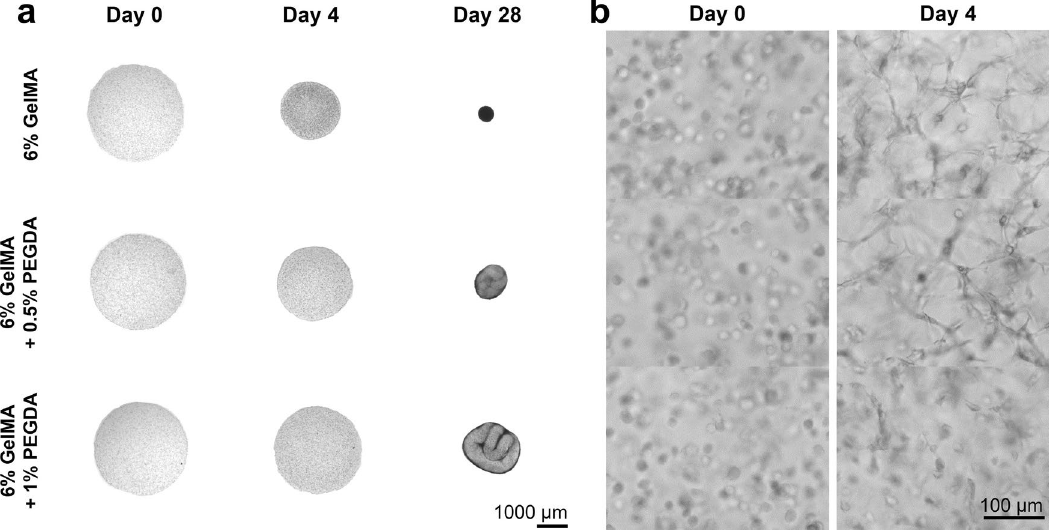
Figure 1. Material testing for fabrication of human jawbone models. ( a ) Dimensional stability of the printed constructs was dependent on the ink composition. ( b ) Cell spread of embedded osteoblasts was observed in all conditions after 4